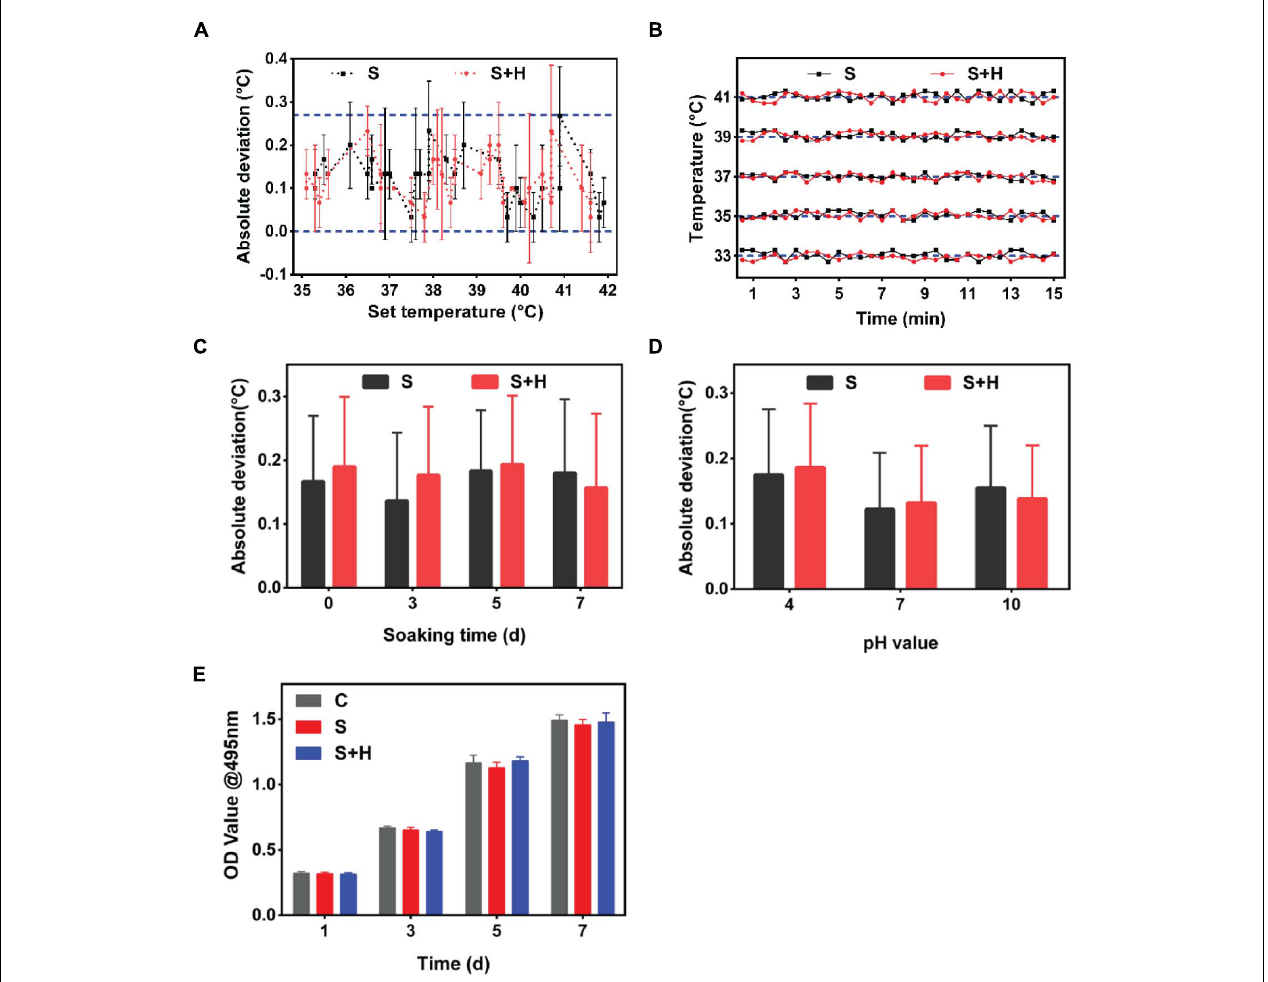
FIGURE 5 | In vitro operation of the integrated smart dressing and its accuracy, stability, biological durability and biocompatibility. (A) Monitoring accuracy of the temperature sensor in the integrated smart dressing, which was defined as the deviation between the recorded average temperatures and the corresponding setting temperatures in the range of 33 ∼ 41 ◦ C. (Label descriptions [here and below]: C, Control; S, Sensor chip; S + H, Sensor chip + Hydrogel.) (B) Monitoring stability of the temperature sensor in the integrated smart dressing. This information was profiled by the time-temperature curves recorded continuously for 15 min at different setting temperatures. (C) Durability of the temperature sensor in the integrated smart dressing, which is presented as the absolute deviation compared with the setting temperature after being soaked in DMEM for different times. (D) Measurement accuracy of the integrated smart dressing after soaking in different pH buffers for 3 days. In the buffer solution of pH 4, the measurement deviation is slightly higher, but the overall deviation is within 0.2 ◦ C. (E) Biocompatibility of the integrated smart dressing, which was evaluated by the viability of L-929 cells cultured in the extract solution. Cells cultured in DMEM served as controls ( n =